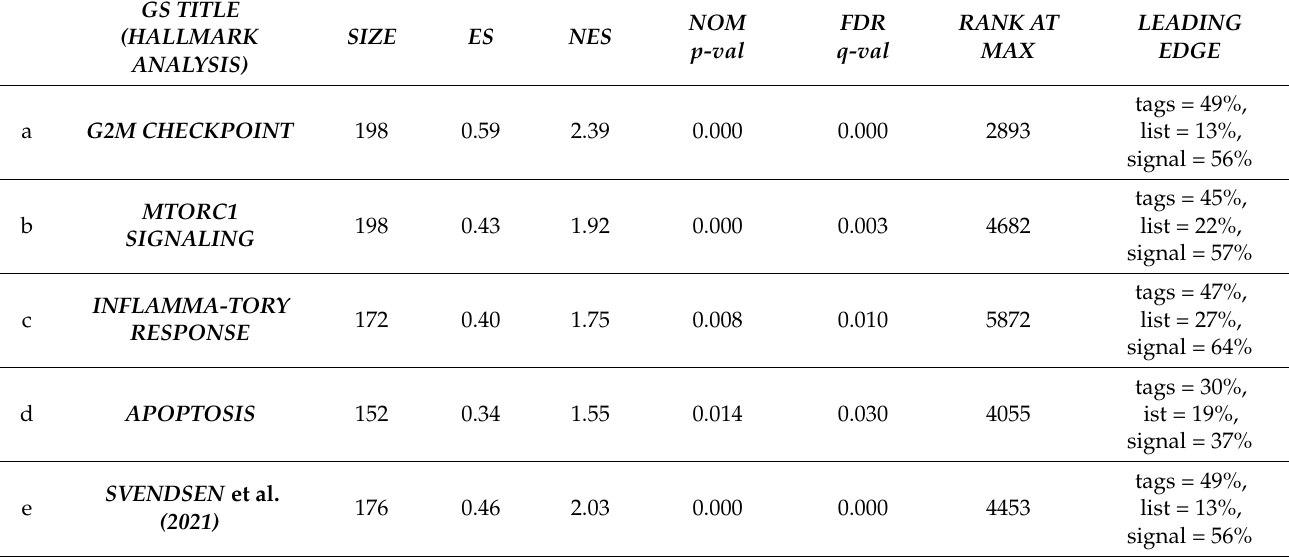
Table 3. Gene set enrichment analysis (GSEA) of the GU high versus GU low